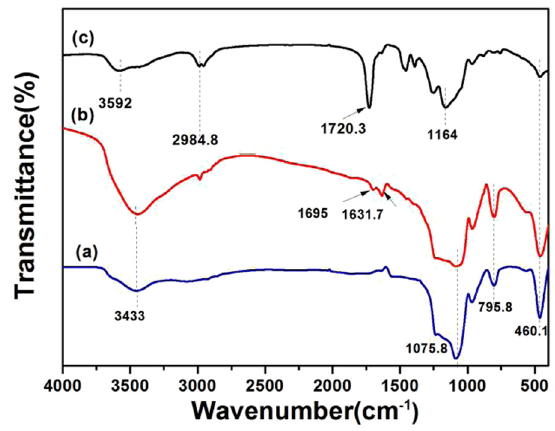
Figure 4: FT - IR spectra of ( a ) MSNs, ( b ) KH570 - MSNs, and